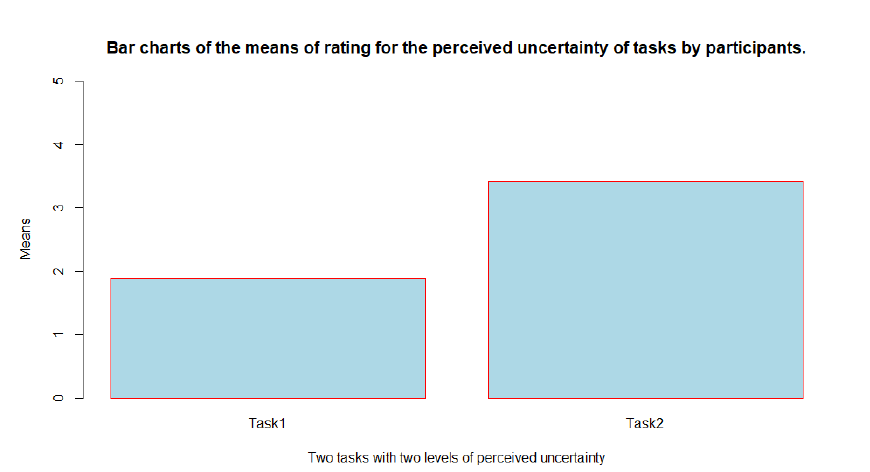
Figure 9. A comparison between the means of ratings obtained from the participants for their perceived uncertainty of Task 1 (M = 1.88, SD = 1.11) and Task 2 (M = 3.41, SD = 1.00); Range of answers = 1–5.